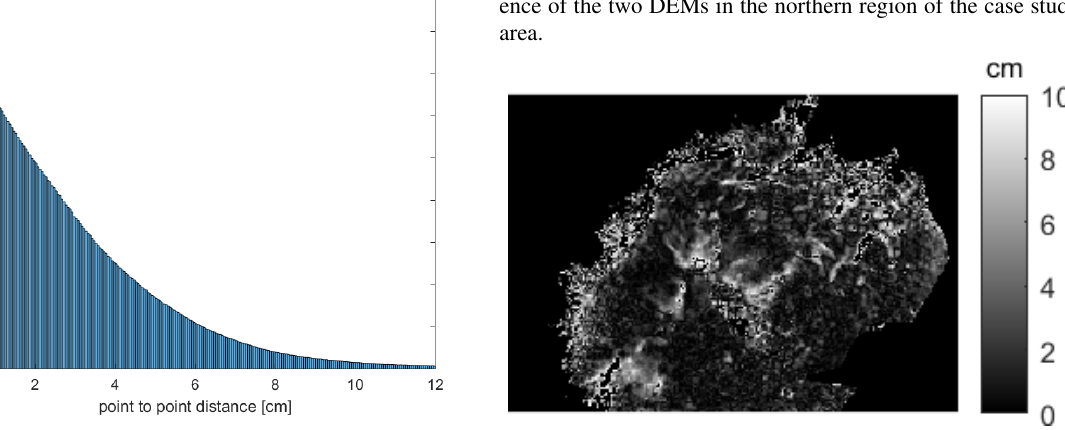
Figure 8. DEM absolute difference (northern region of the considered study area): photogrammetric survey vs ToF